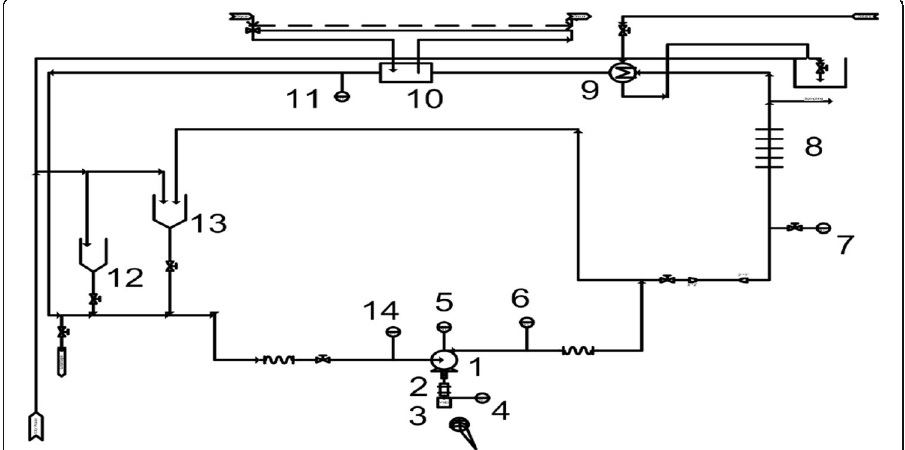
Fig. 11 Process flow chart of fault diagnosis test system for slurry pump